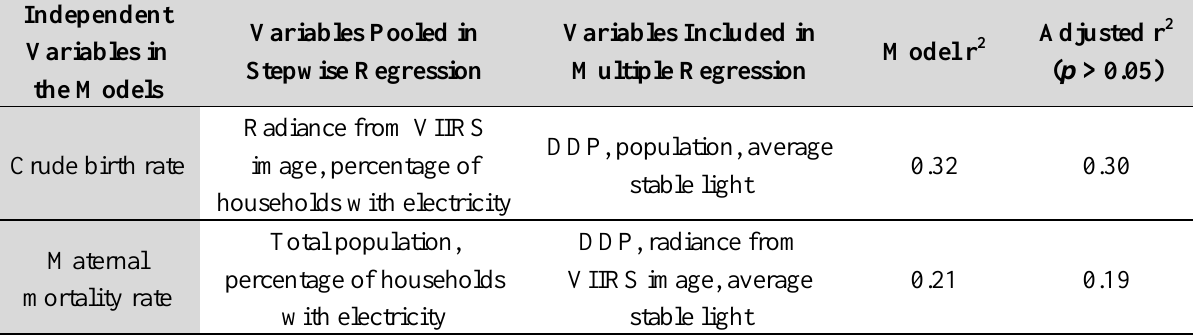
Table 6. Variables pooled and included in the models to predict CBR and